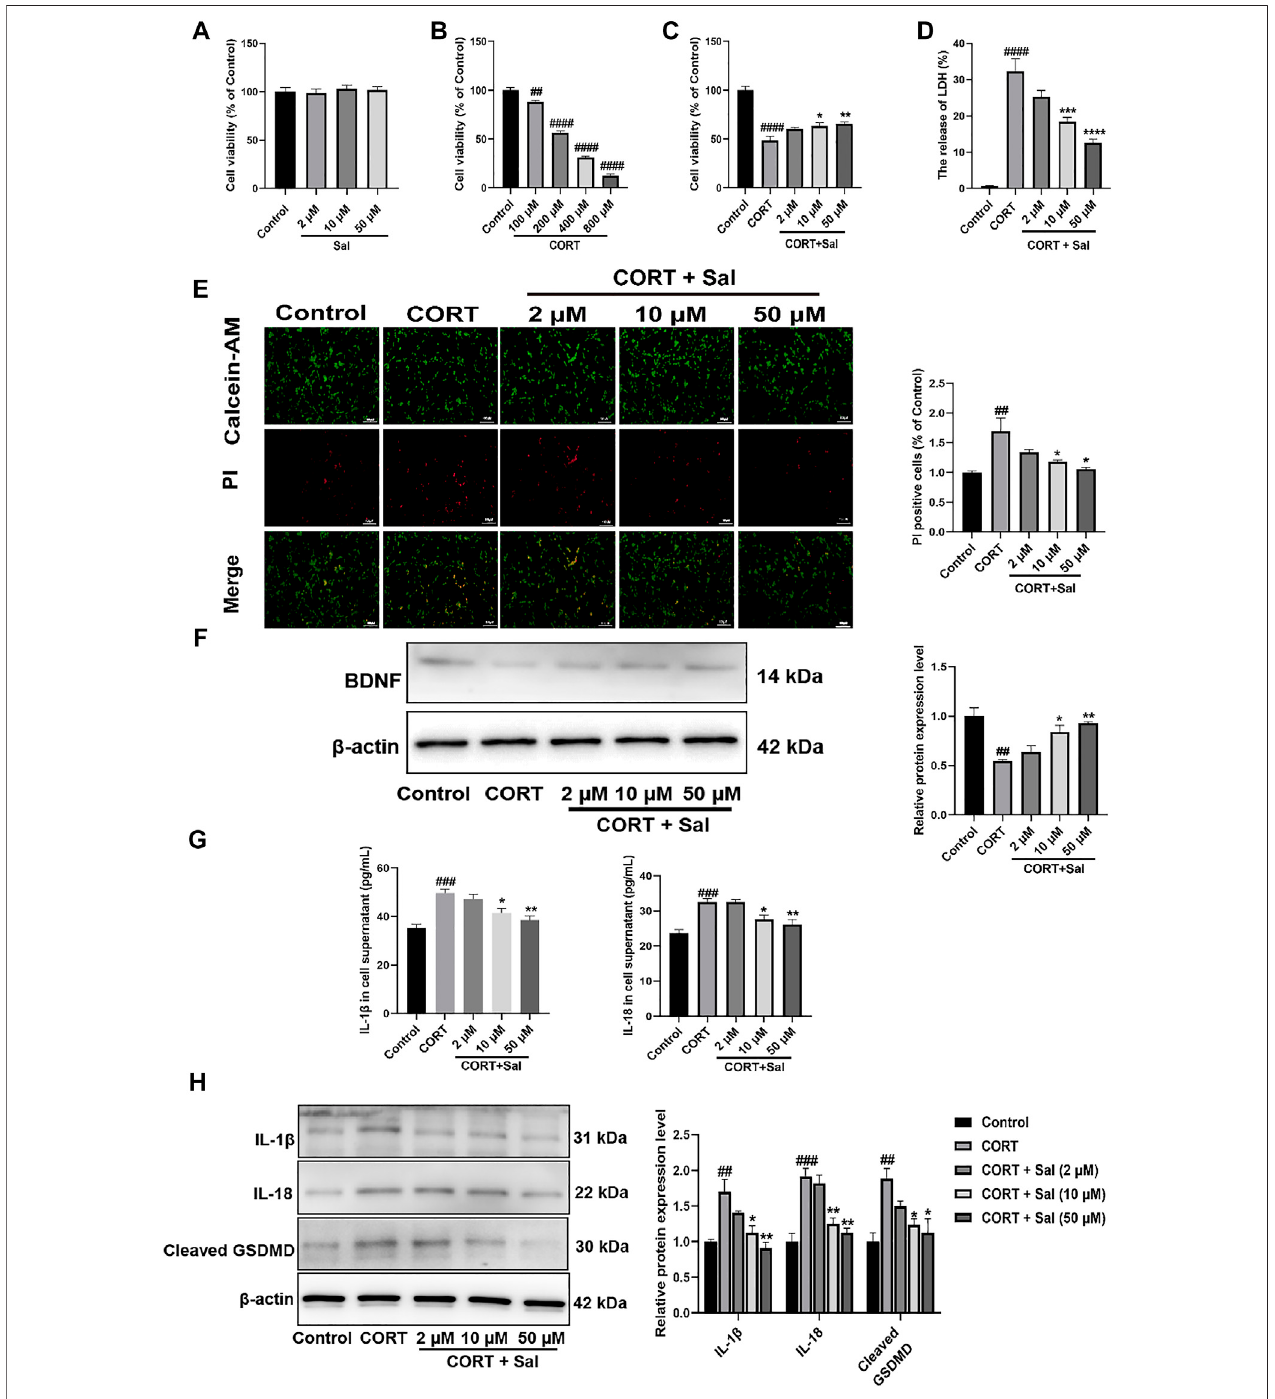
FIGURE 7 | Sal ameliorates CORT-induced PC12 cells. (A – C) The cell viability was measured by CCK-8 assay ( n = 6). (D) The release of LDH was determined by LDH assay ( n = 6). (E) Calcein-AM/PI staining images were captured by fl uorescence microscopy, Calcein-AM (in green), PI (in red). Original magni fi cation: ×200, Scale bar =100 μ m( n = 3). (F) Western blotanalysis shown thatSal increased BDNF expression in CORT-induced PC12 cells ( n =3). (G) The expression ofIL-1 β and IL-18 in PC12cellsupernatantwasdetectedbyELISA( n =5). (H) ThelevelsofIL-1 β ,IL-18andcleavedGSDMDinsupernatantofPC12cellwereanalyzedbyWesternblot ( n =3).[ (A) PC12cellswerecultured withvariousconcentrationsofSal(2,10,50 μ M)for24 h (B) PC12cellsweretreatedwithincreasingdosesofCORT(100 – 800 μ M) for 24 h (C – H) PC12 cells were incubated with Sal (2, 10, 50 μ M) for 2 h, and then cultured with 200 μ M CORT for 24 h] #### p < 0.0001, ### p < 0.001, ## p < 0.01 compared to the control group; ** p < 0.01, * p < 0.05 compared to the CORT group.